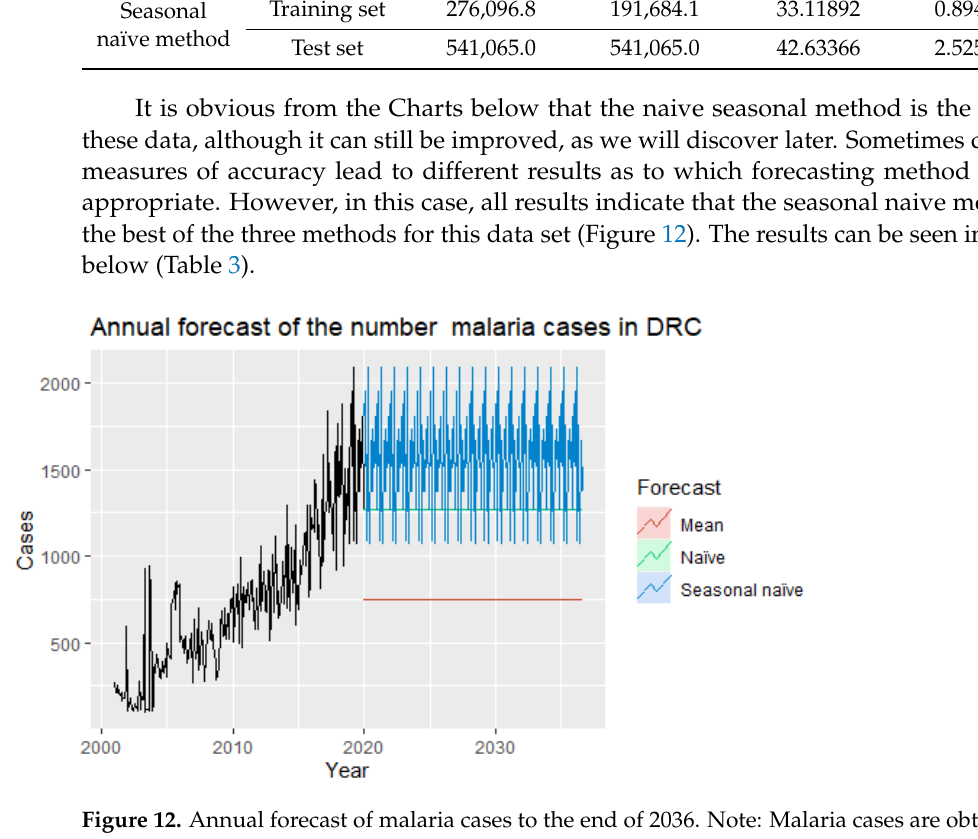
Table 2. Test for evaluating the accuracy of the forecasts.